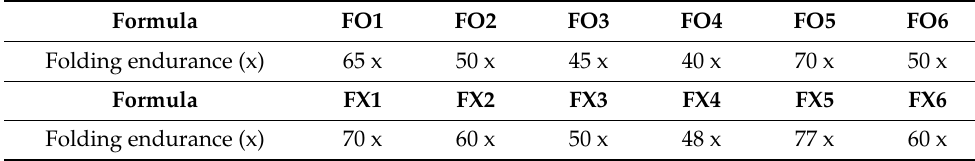
Table 4. Folding endurance of the orodispersible